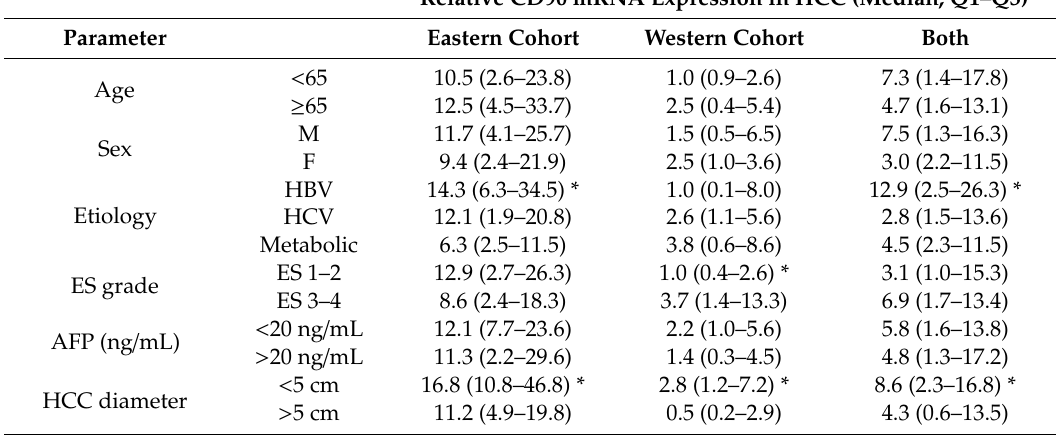
Table 2. Correlation between CD90 mRNA expression in HCC nodule and demography and clinical parameters of